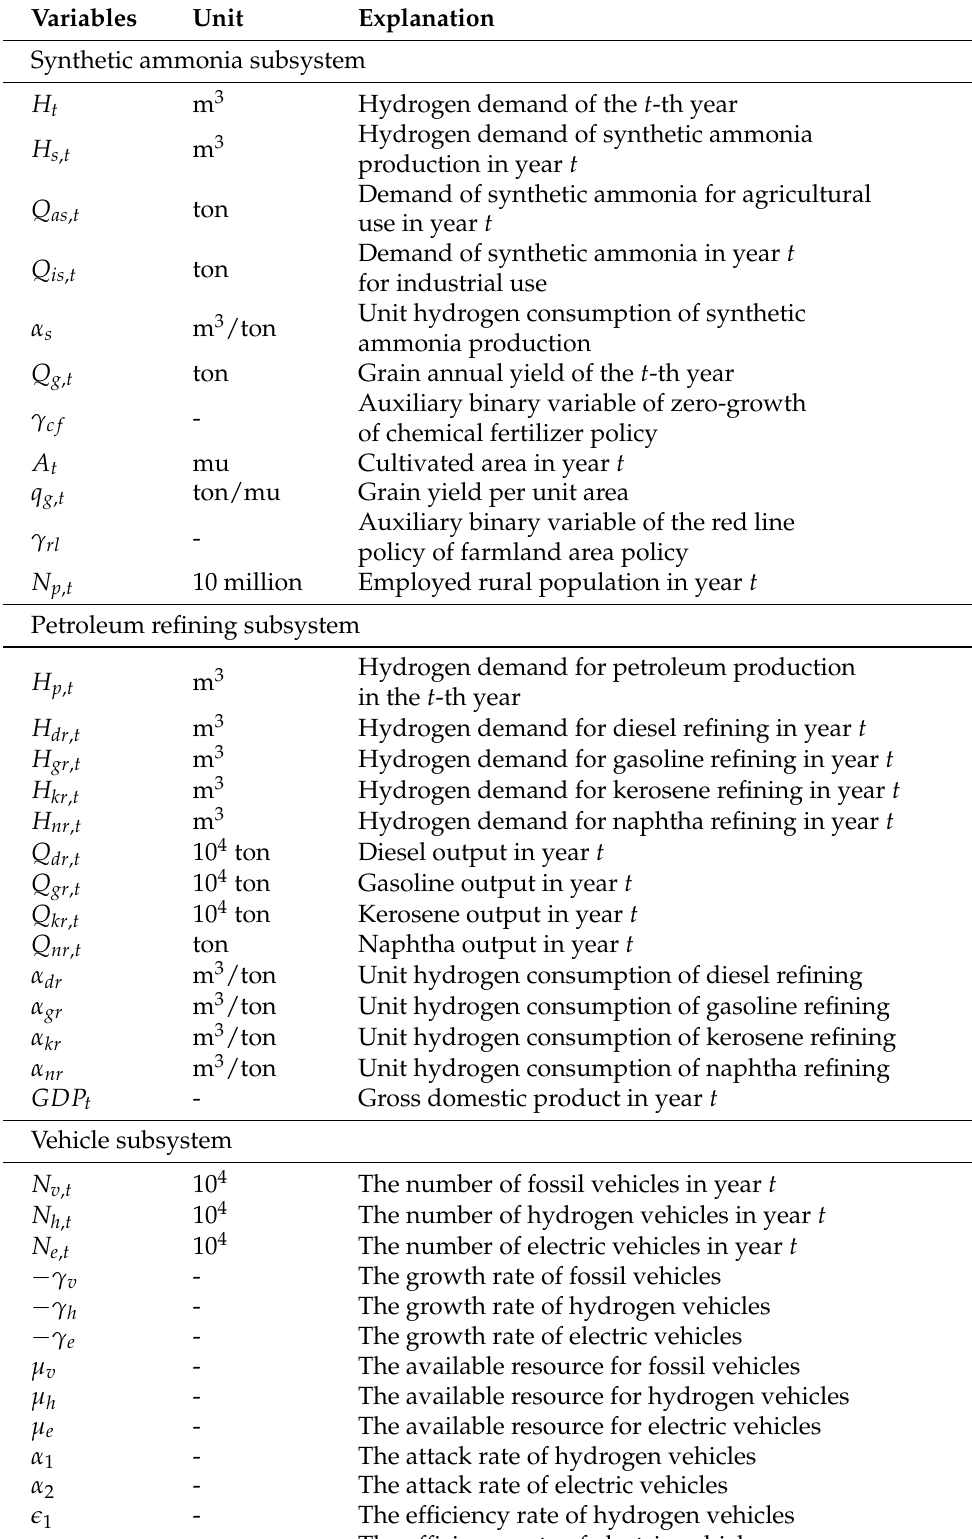
Table 3. Variables and